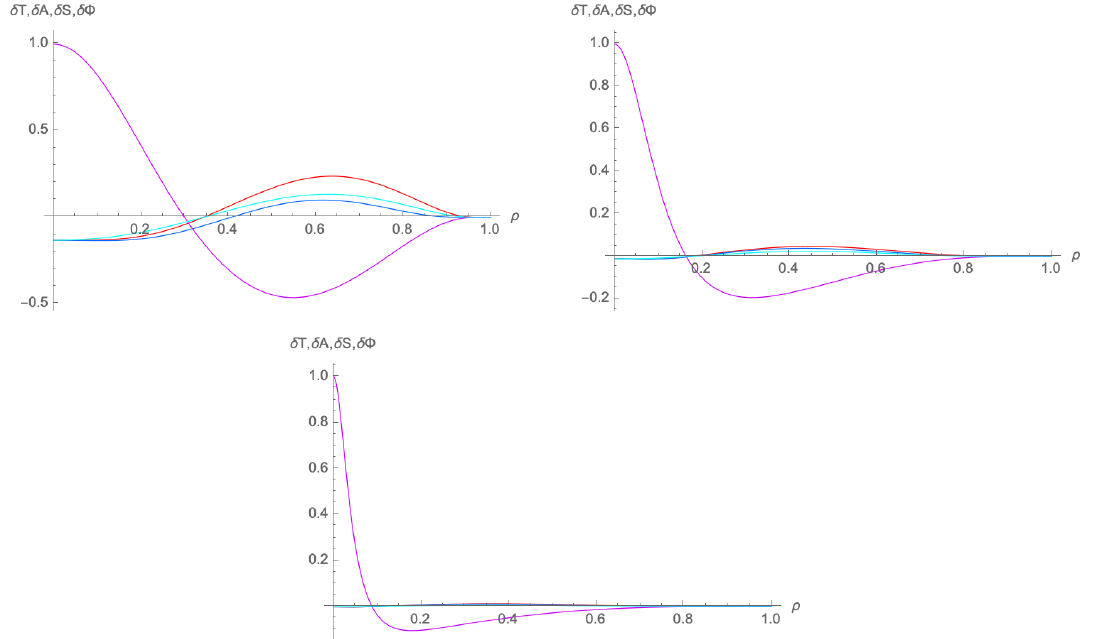
Figure 5 . Similar to the previous figure, the wavefunctions for the second most unstable mode are shown for perturbations of electrically charged RN, for r − = 0 . 9 (top left), r − = 0 . 99 (top right) and r − = 0 . 999 (bottom). We see the wavefunctions have one node, and again δS grows relative to the other component functions at the horizon as extremality is